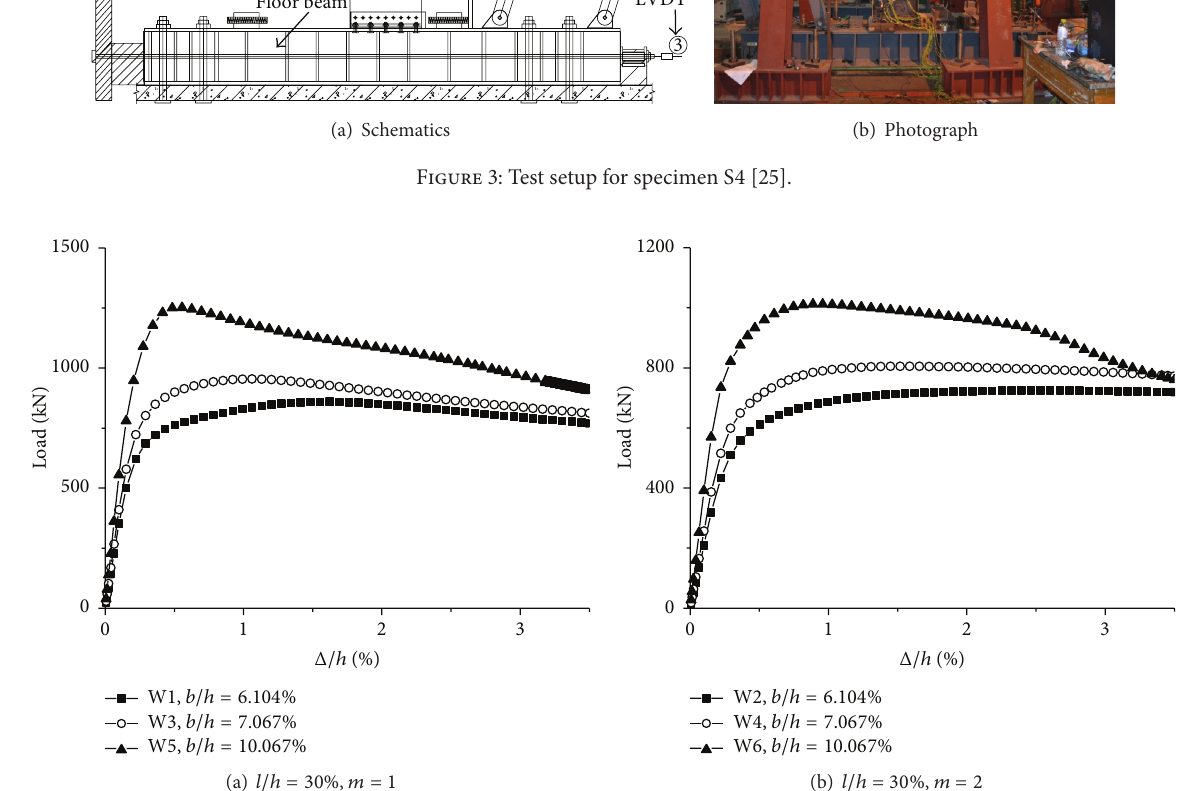
Figure 4: Pushover curves of steel slit walls with different 𝑏/ℎ